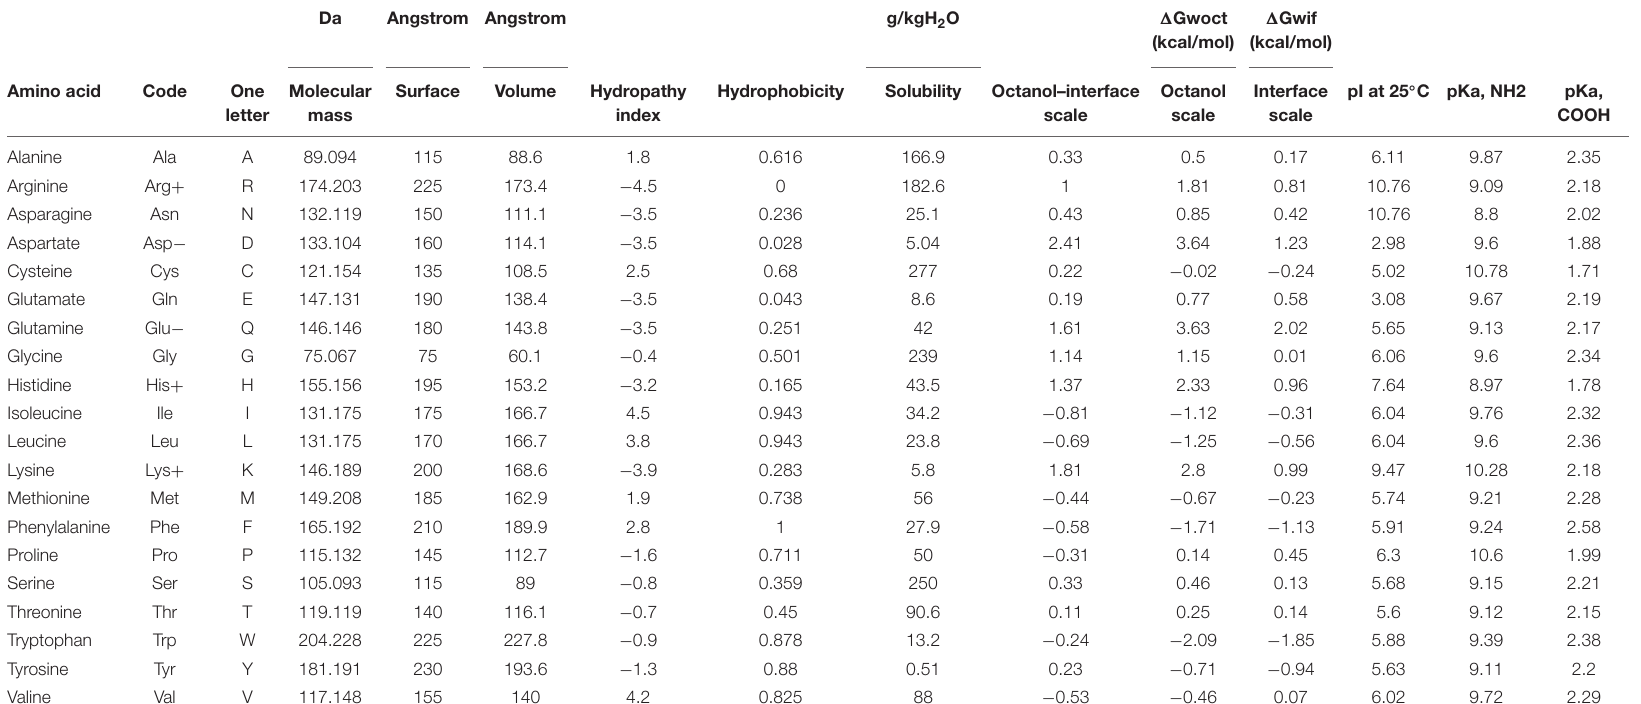
TABLE 1 | Physico-chemical properties of individual amino